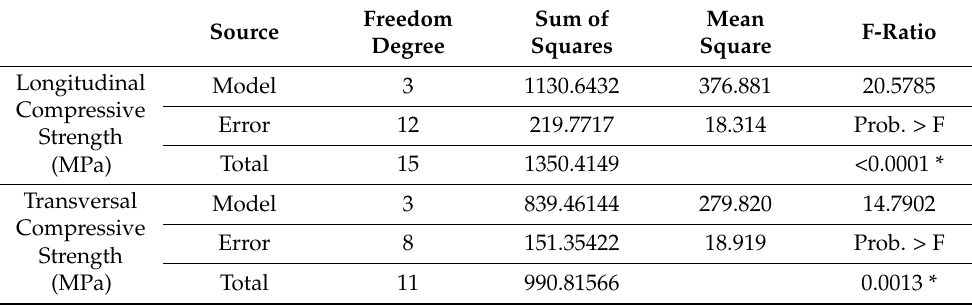
Table 10. Variance analysis (ANOVA) of derived models.